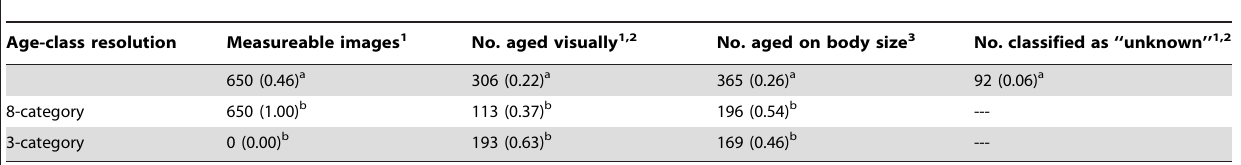
a Proportions in parenthesis are relative to 1,413 attempted measurements. b Proportions in parenthesis are relative to the column totals given in the 1 st row. 1 Column only includes larger animals where aging required tusk and snout measurements. 2 An attempt was made to find a measurable image but none with the requisite perfectly perpendicular front or side view was found, and only a visual estimate of age was made or age was classified as unknown. 3 Column only includes smaller animals where aging did not require tusk or snout